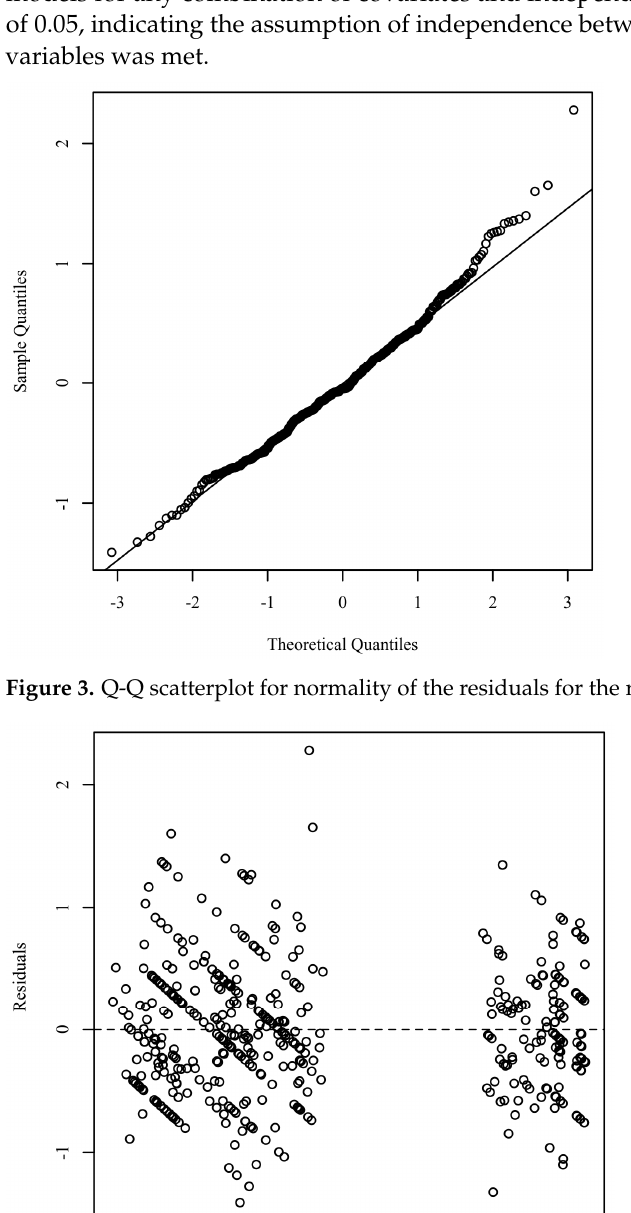
Figure 2. The difference between means at baseline ( a ), 3 ( b ) and 6 ( c ) months.